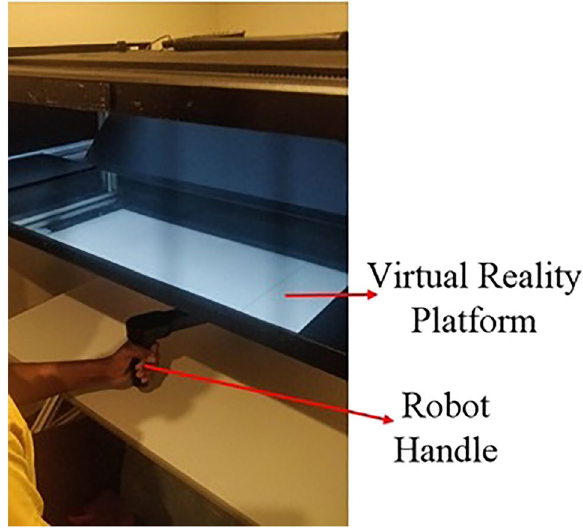
Figure 1. A closer look at the KINARM end point robot with a subject.